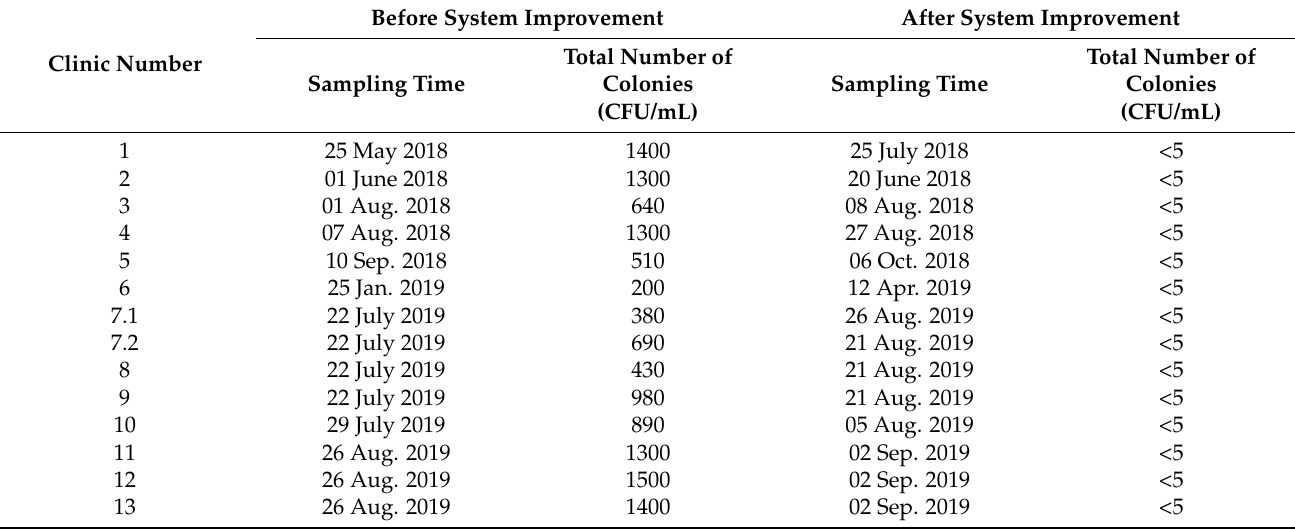
Table 5. Comparison of total colony counts before and after water quality improvement in dental